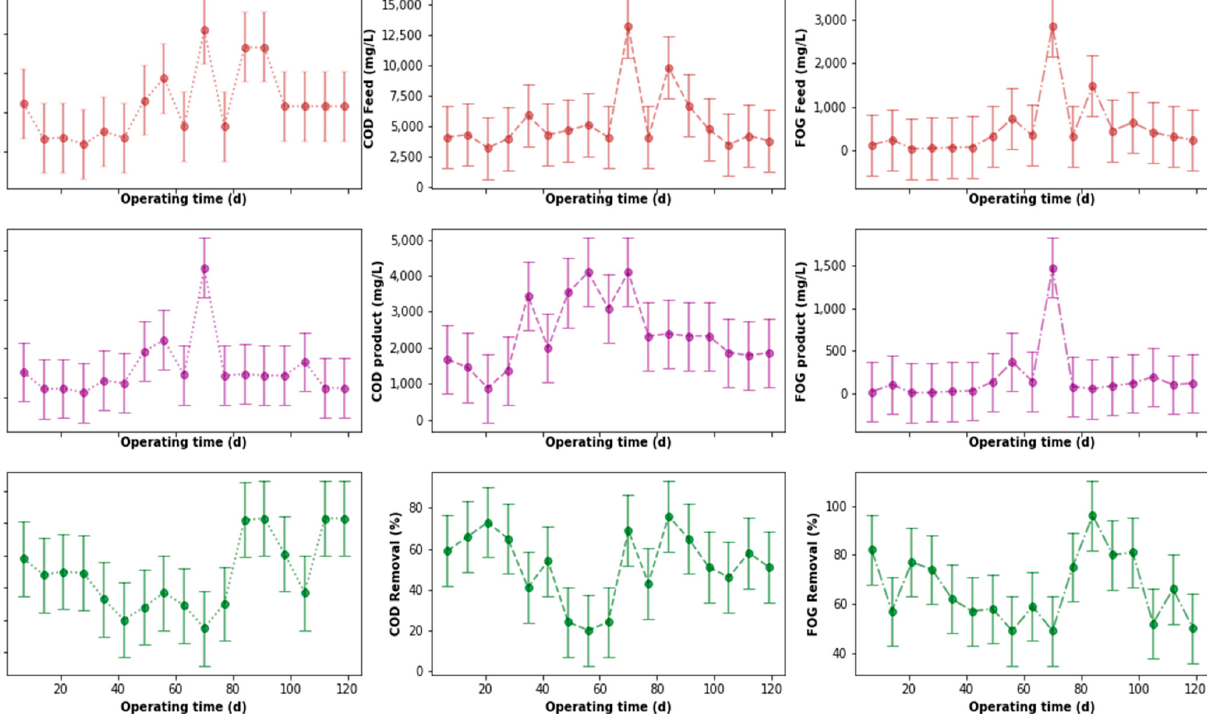
( b ) After anomaly detection and correction Figure 4. Boxplots of each pre ‐ treatment parameter distribution before and after anomaly detection and correction. A further analysis of the effects of the outliers’ replacement is illustrated in Figure 5, from which a change in the value of the kurtosis, skewness, mean, and standard deviation